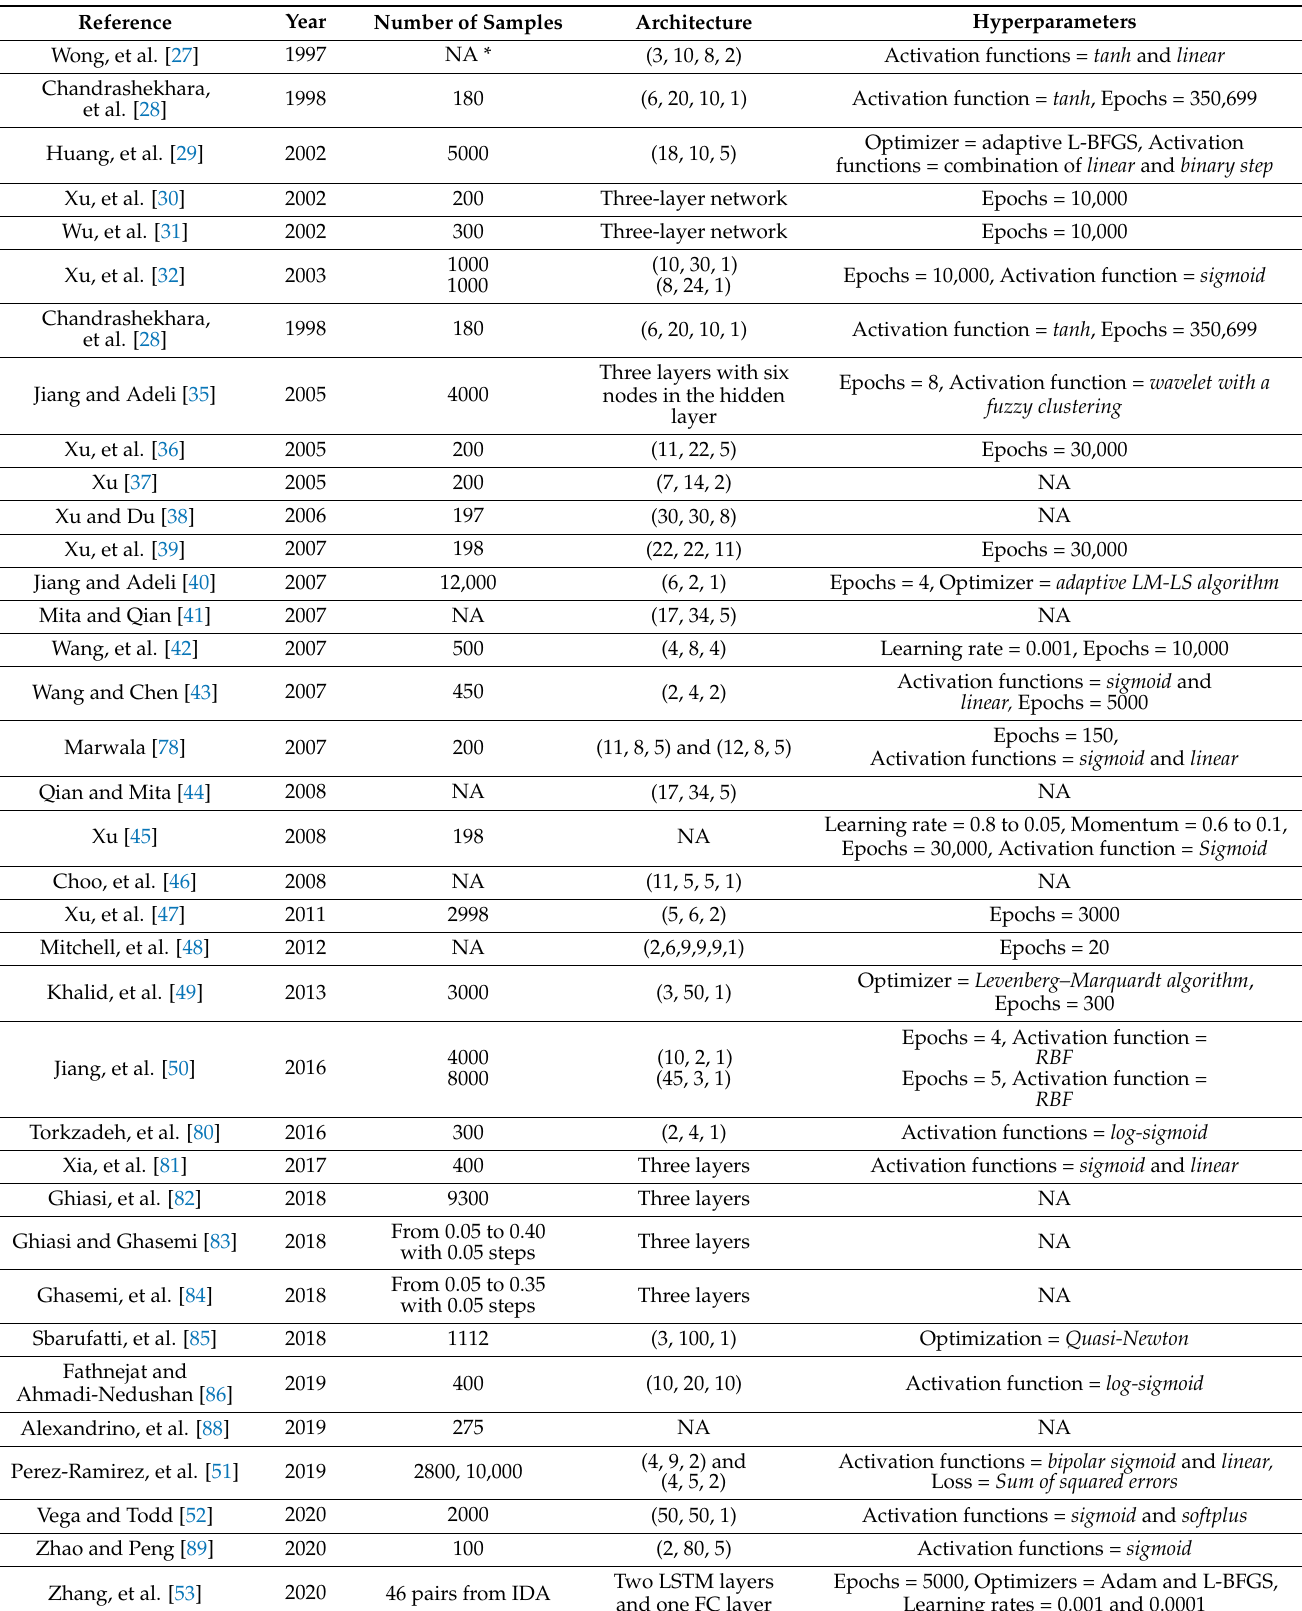
Table 3. The number of samples and reported hyperparameters of reviewed